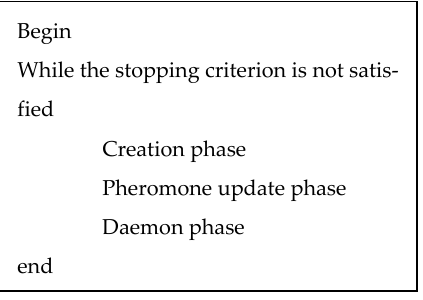
Return the best solution Figure 2. Ant colony optimization algorithm pseudocode [28,29]. Figure 2. Ant colony optimization algorithm pseudocode